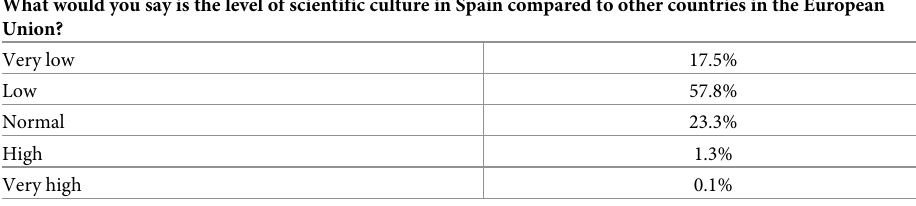
Table 5. Scientists’ views of the level of scientific culture in Spain. What would you say is the level of scientific culture in Spain compared to other countries in the European Union?